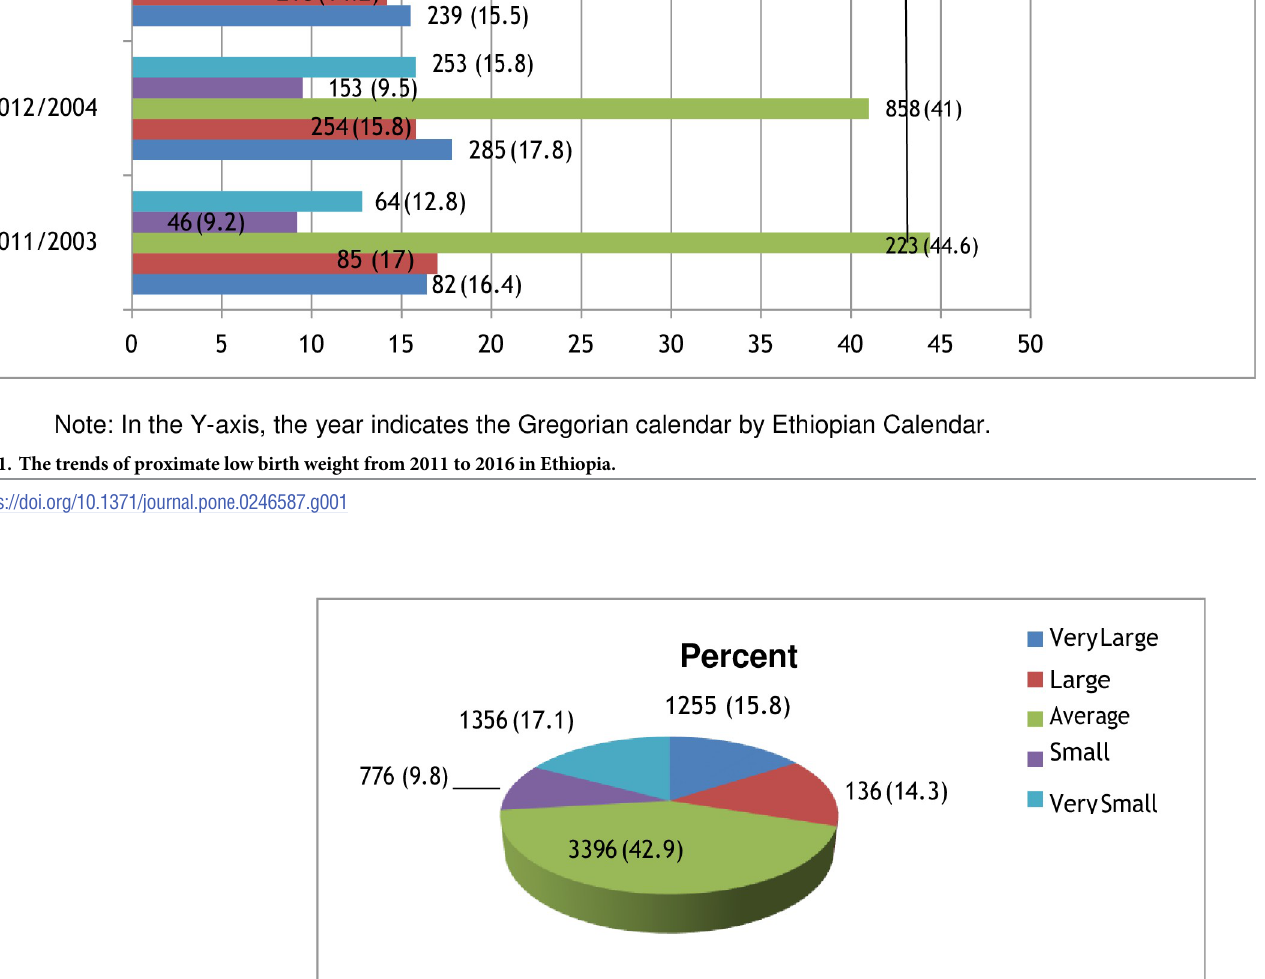
PLOS ONE | https://doi.org/10.1371/journal.pone.0246587 February 10, 2021 8 /